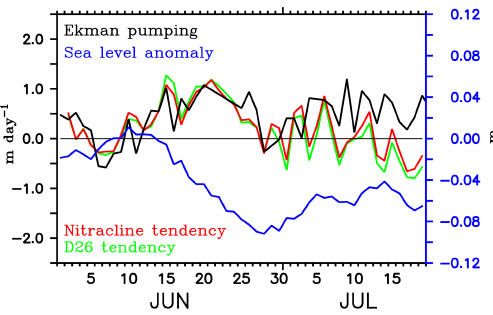
Figure 14. Ekman vertical velocity (mday − 1 ; black) and tenden- cies of nitracline (mday − 1 ; red) and D26 (mday − 1 ; green) aver- aged over the region of the modelled Sri Lanka Dome. Note that the tendency terms are reversed in sign so that positive values indicate shoaling and the negative values indicate deepening. D26 is taken as the depth of the 26 ◦ C isotherm. Nitracline is defined as the depth of 2µmolkg − 1 nitrate isoline. Minimum sea level anomaly (m; blue) in the region of the SLD is overlayed.